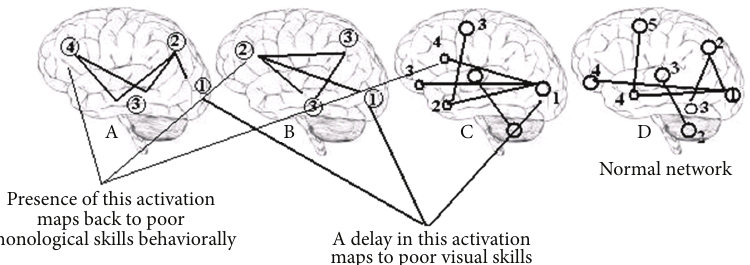
Figure 1: Individual dyslexic readers (brains A, B, C) may develop their own unique cortical networks, but common deficits map back onto common behavioural deficits. Brain D here is from Kujala et al. [54] representing normal network connectivity when reading.